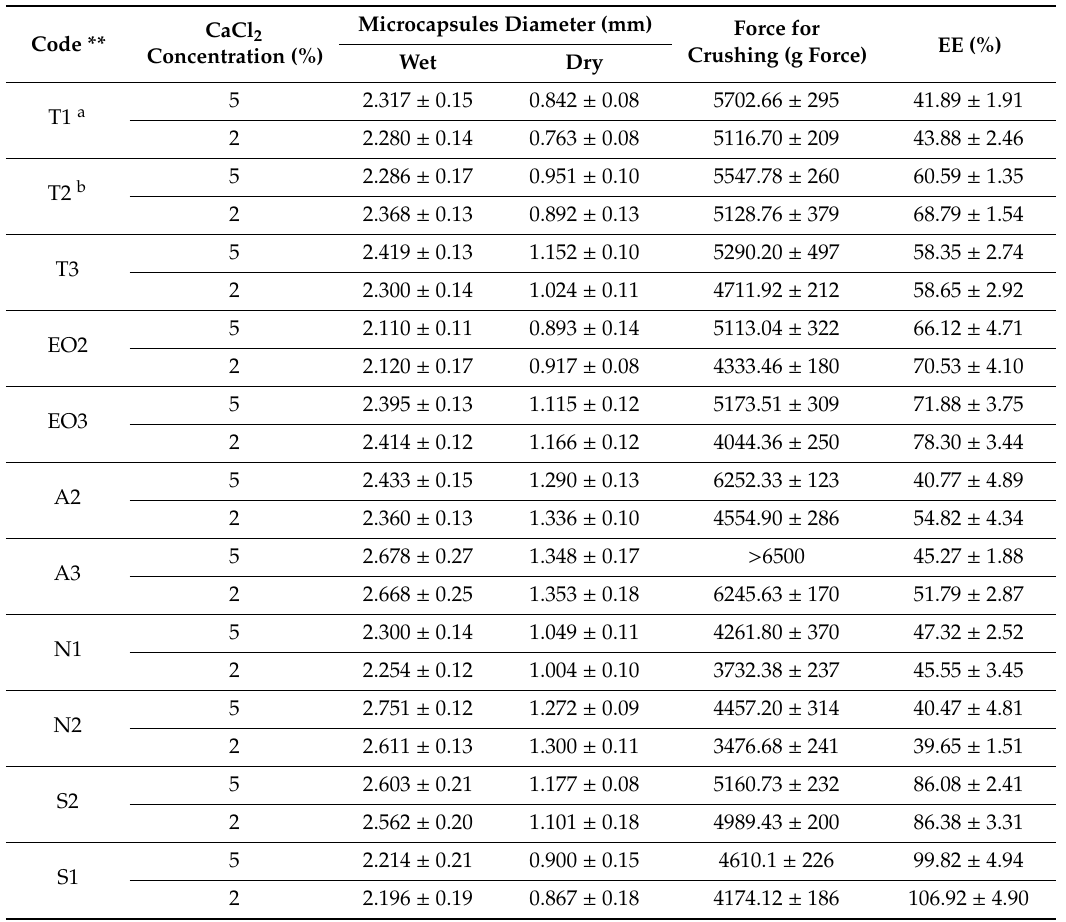
Table 2. Parameters of NEO-loaded microcapsules (crosslinker CaCl 2 concentration; diameter of dry and just made (wet) microcapsules (mm); force required to crush wet capsules (g force); e ffi ciency of encapsulation